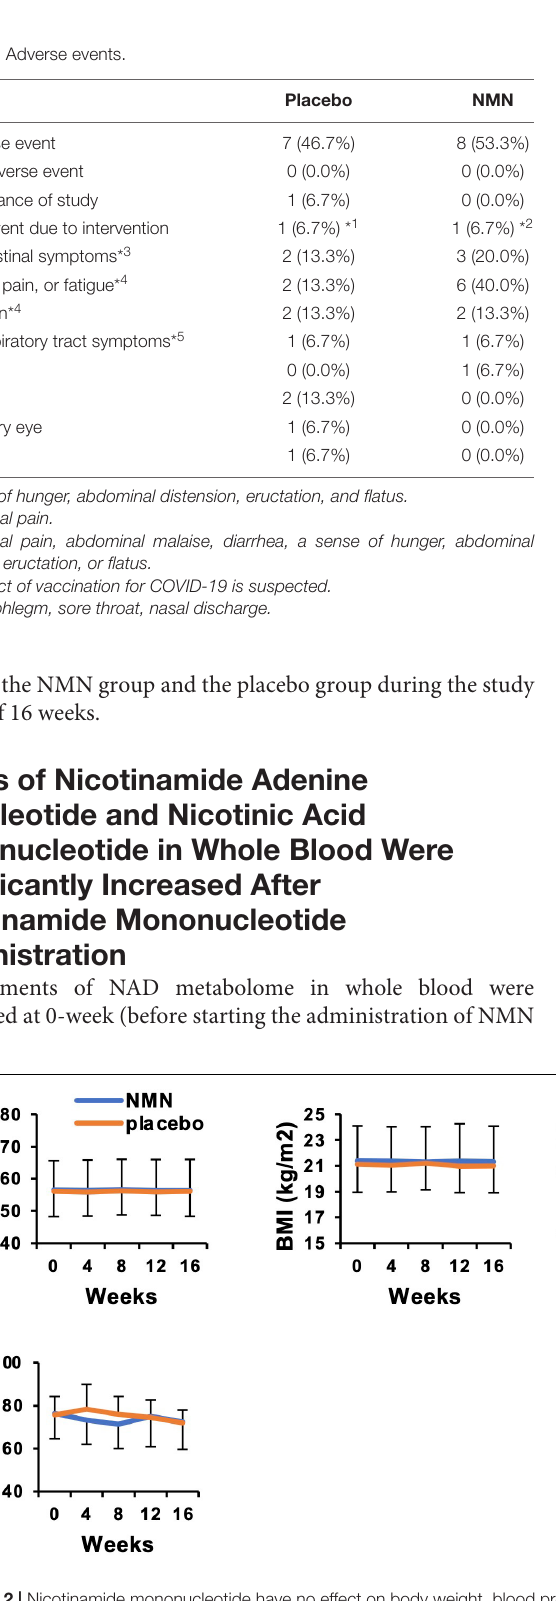
Frontiers in Nutrition |